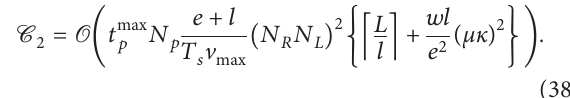
Table 1: Numerical simulation parameters. Simulation